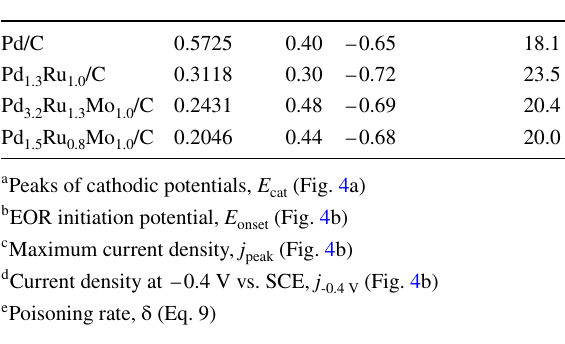
Table 4 Electrochemical data obtained by cyclic voltammetry and chronoamperometry